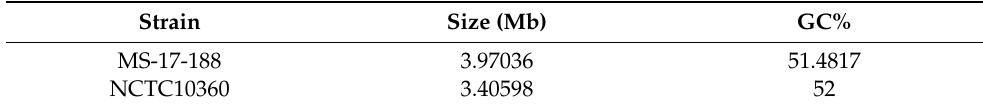
Table 1. Size and GC content of P. shigelloides genomes.